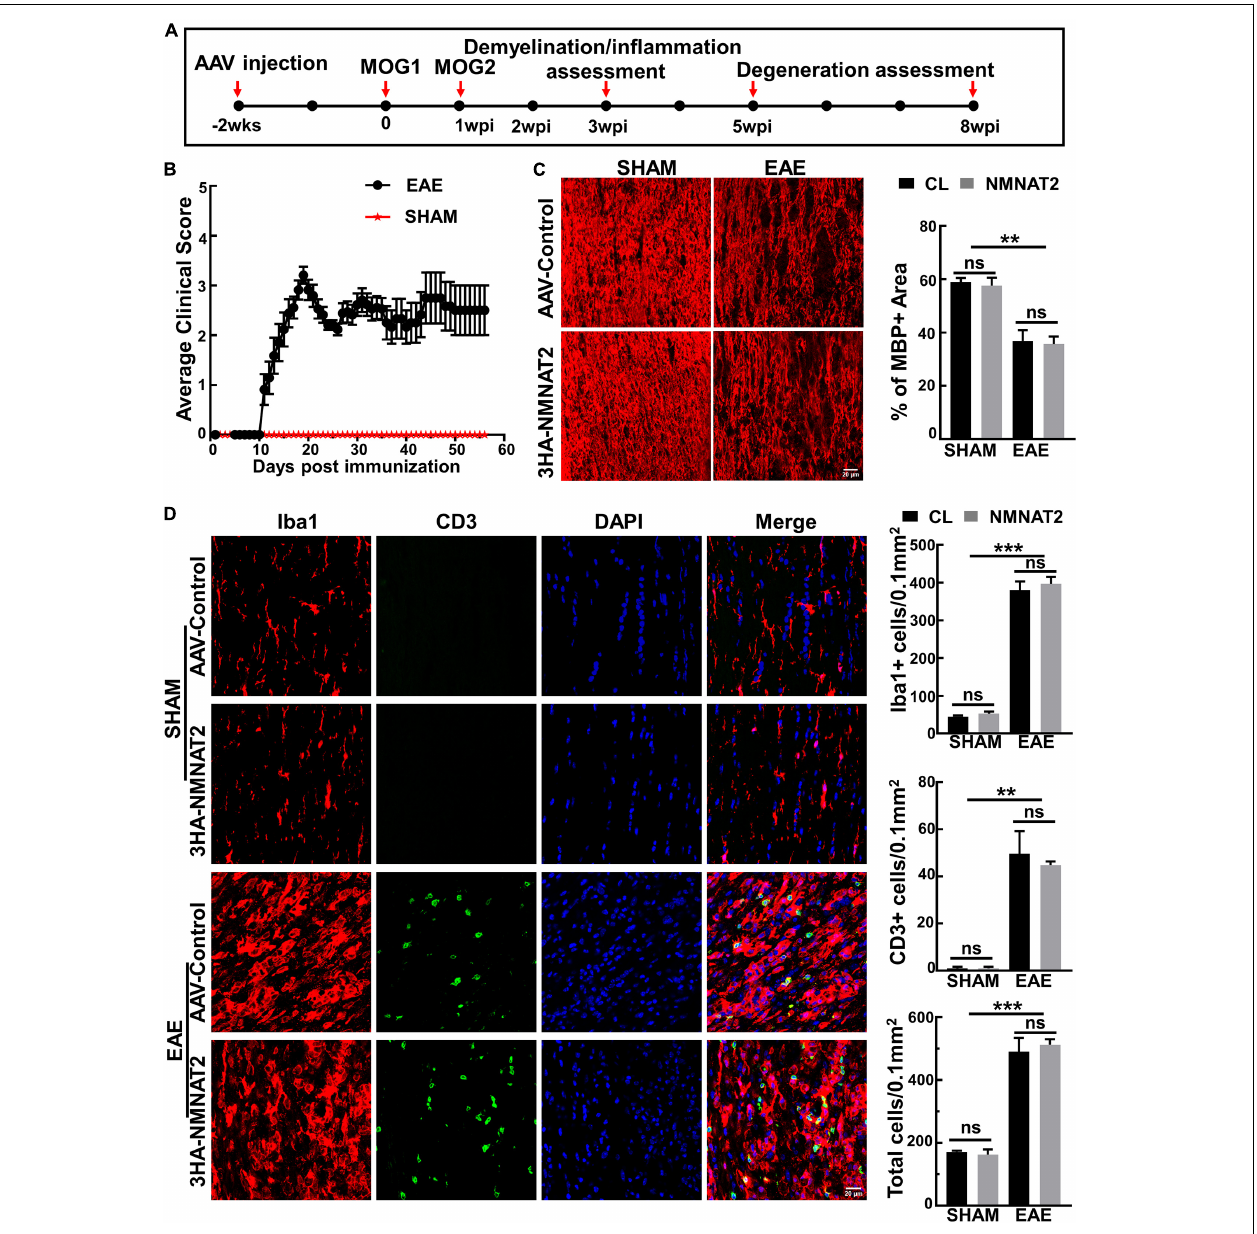
FIGURE 2 | NMNAT2 (cid:49) ex6 overexpression does not reduce inflammation or demyelination of the ON in experimental autoimmune encephalomyelitis (EAE)/optic neuritis. (A) Timeline of experimental design showing AAV injection at 2 weeks before first myelin oligodendrocyte glycoprotein (MOG) immunization, second MOG immunization at 1 week post first immunization (1 wpi), inflammation assessment at 3 wpi, and degeneration analysis at 5 and 8 w pi. (B) Clinical scores of MOG immunized EAE mice and sham control mice at different time points (days post immunization). Data are presented as means ± SEM. EAE group, n = 17; sham group, n = 3. (C) MBP immunostaining of ON longitudinal sections showing comparable ON myelin basic protein (MBP) decreasing/demyelination in the eyes injected with AAV2-3HA-NMNAT2 (cid:49) ex6 and contralateral control eyes injected with control AAVs at 3 wpi; while there is no ON demyelination in the sham group. Scale bar, 20 µ m. Quantification of the percentage of MBP + area to the whole ON area were shown as means ± SEM, n = 3. ns, no significance; ** p < 0.01, one-way ANOVA with Tukey’s multiple comparisons test. (D) Confocal images of the ON longitudinal sections showing significantly increased inflammatory cell infiltration in the EAE mice at 3 wpi with or without NMNAT2 overexpression, but not in the sham control mice. Scale bar, 20 µ m. Quantification of Iba1 + , CD3 + , and DAPI + total cells in the ONs: Data are presented as means ± SEM, n = 3; ns, no significance; ** p < 0.01, *** p < 0.001, one-way ANOVA with Tukey’s multiple comparisons test.